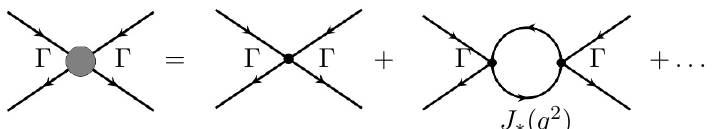
Figure 13 . Perturbative expansion of the T-matrix elements T ( q 2 ) regarding the current inter- 0 (cid:6) action (cid:0) for the scalar channel (cid:0) = 1 ( (cid:27) = 0 + ) and the pseudo-scalar channel (cid:0) = i(cid:13) 5 ( (cid:25) = 0 (cid:0) ). exists for a dynamical mass m < M below the St(cid:127)uckelberg mass scale (as the natural cut- St o(cid:11) scale), provided that the gauge coupling of the U(1) gauge theory exceeds a critical